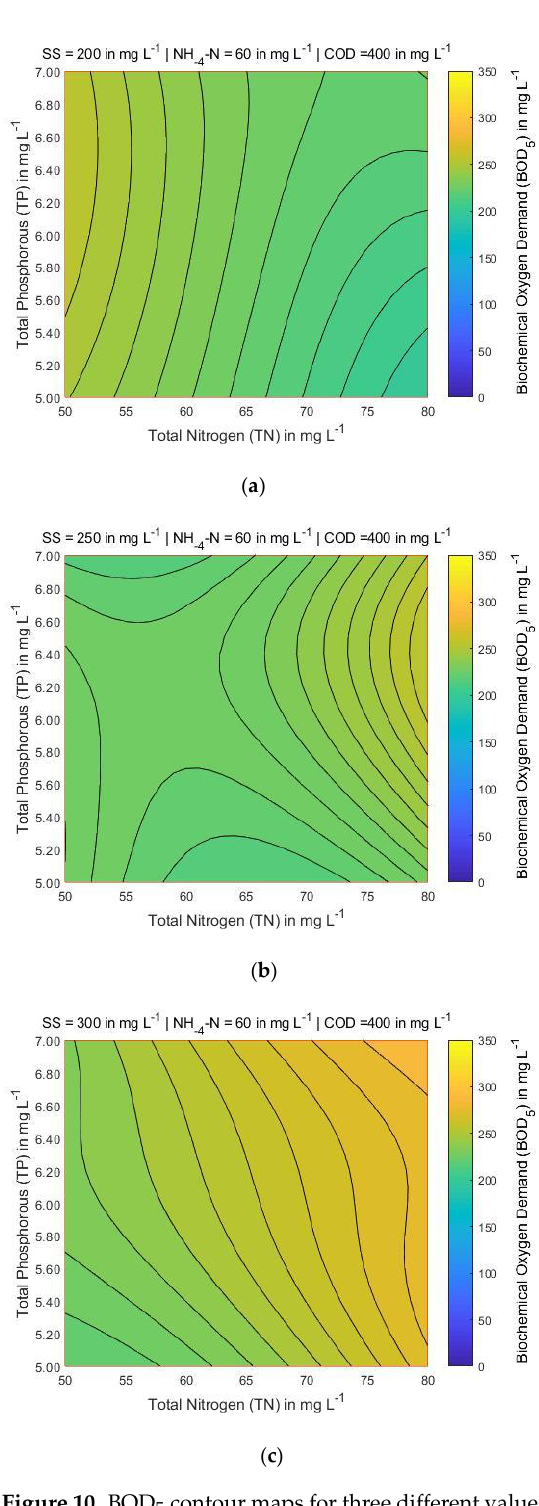
Figure 10. BOD 5 contour maps for three different values of SS (in mg L − 1 ) while NH 4 -N = 60 mg L − 1 and COD = 400 mg L − 1 are constant: ( a ) SS = 200; ( b ) SS = 250; and ( c ) SS =